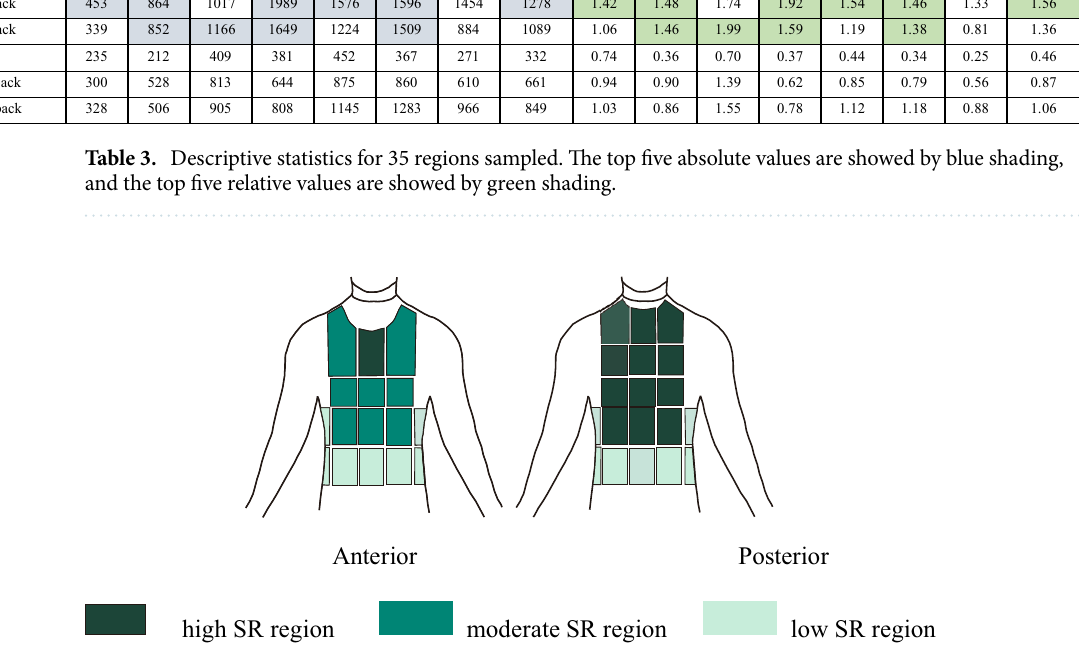
Figure 7. Zone map for upper body sweat rates The figure was created using Coreldraw Version